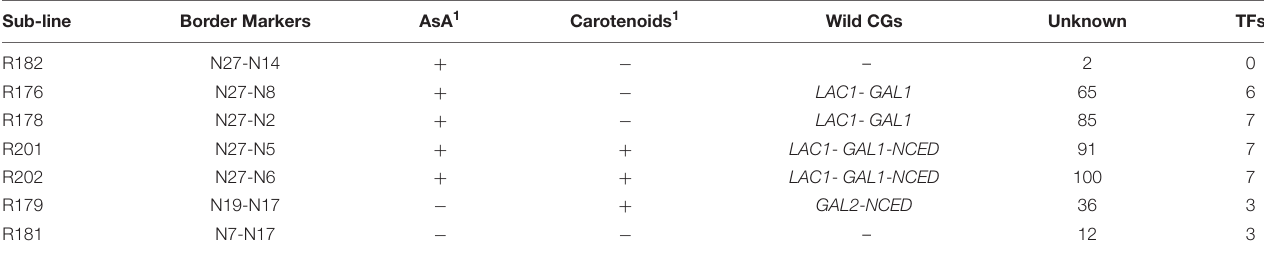
TABLE 4 | Phenotyping and genotyping of the seven S. pennellii introgression sub-lines: for each sub-line the higher content of ascorbic acid (AsA) and total carotenoids respect to M82 is reported, together with the presence of wild alleles for four candidate genes (CG), and the number of genes classified as unknown and transcription factors (TF), which map in the introgressed